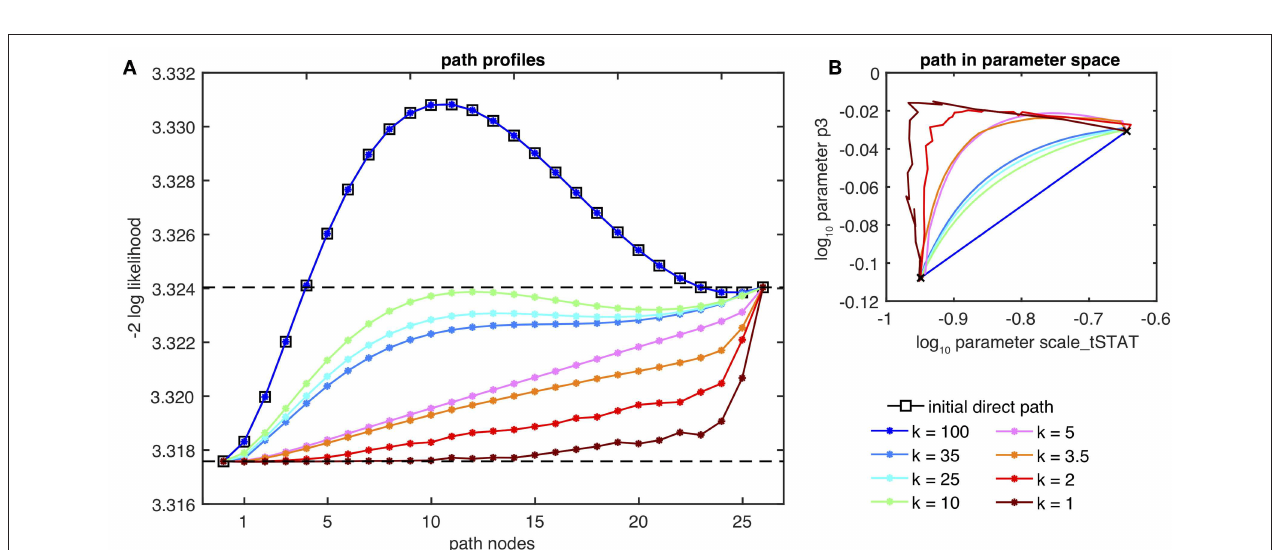
FIGURE 5 | Optimal paths from the NEB method for several spring constants k from fit # 1 to # 13 of the intentionally suboptimal setup for the JAK/STAT signaling model (c.f. Figure 4A ). (A) Shows the path profiles of the NEB approach, as well as, for the initial, i.e., direct path. (B) Depicts the same paths in an illustrative choice parameter